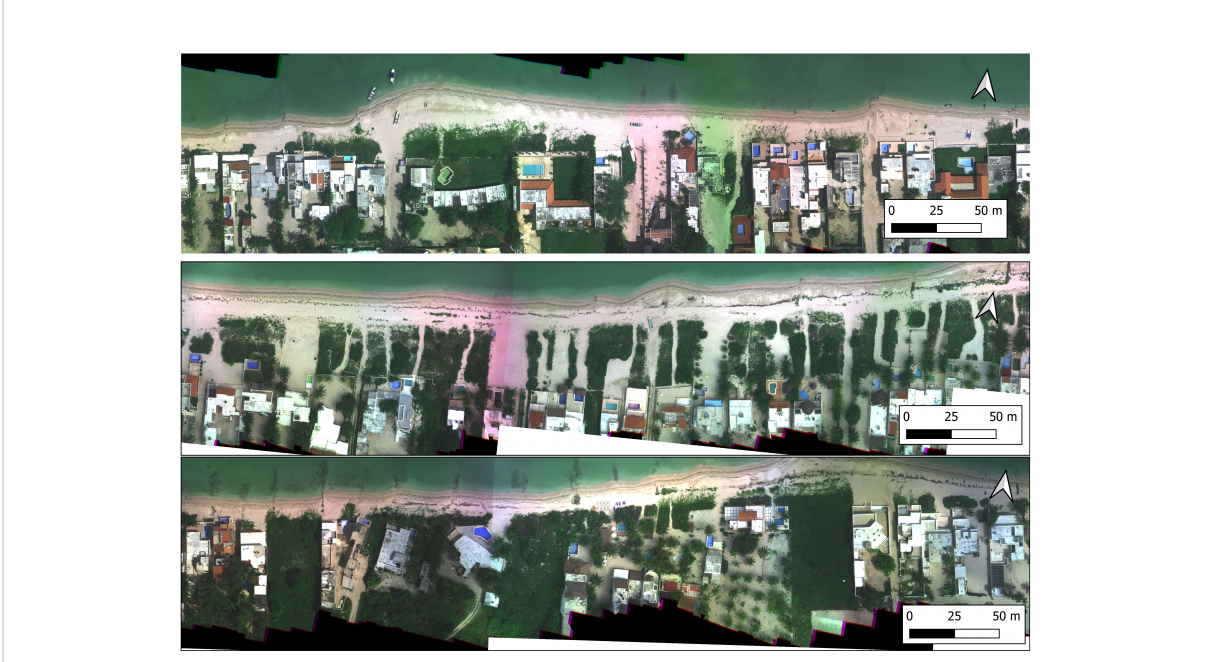
FIGURE 10 Examples of the heavily urbanized character, and low vegetation coverage, of the study